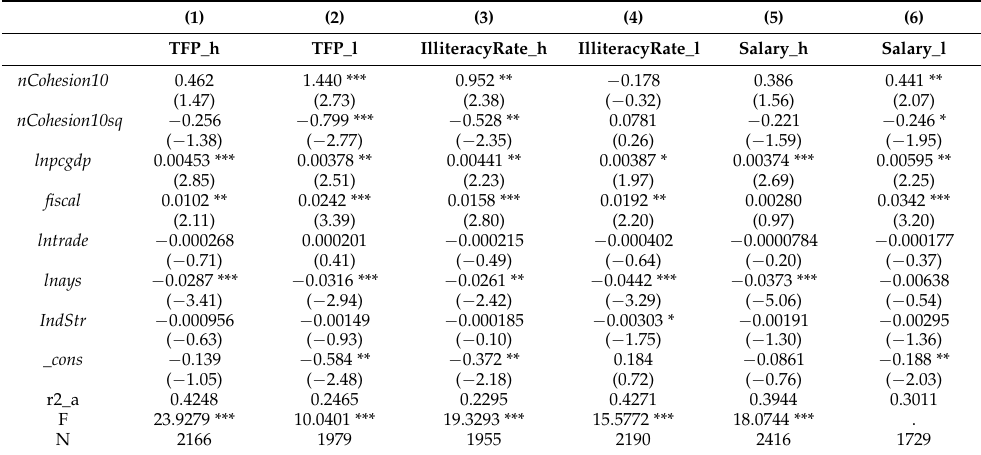
Table 3. Heterogeneous effects: impact of city shape on urban poverty.